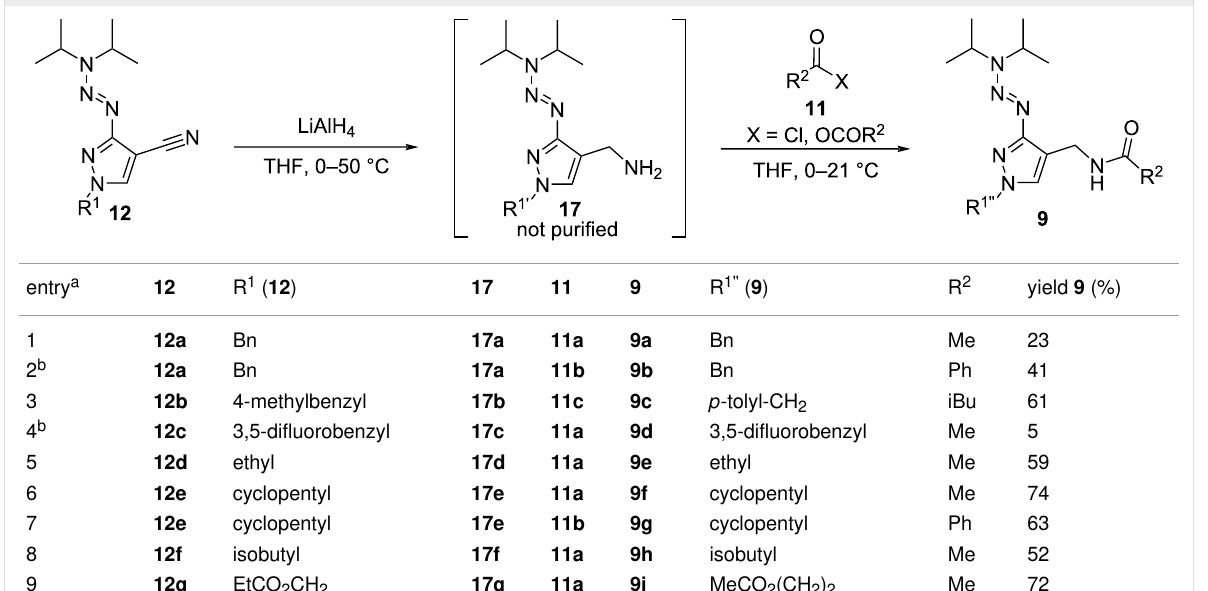
Table 2: Synthesis of amides 9a – i via reduction of nitriles 12a – g to pyrazolo- ortho -methylamines and subsequent conversion with aliphatic anhy- drides or chlorides 11a – c